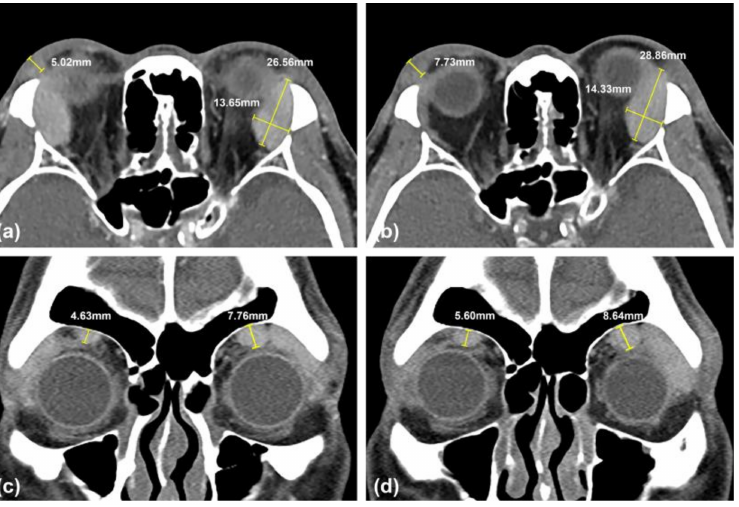
Figure 3. Contrast-enhanced CT of the orbits before orbitotomy ( a , c ) and six months after orbitotomy ( b , d ). ( a ) Axial view revealing bilateral enlargement of the lacrimal gland and right upper eyelid’s homogenous enhancement with an irregular border. The size of the left lacrimal gland was 26.56 mm × 13.65 mm. The thickness of the right upper eyelid mass was 5.02 mm. ( b ) Axial view revealing >90% reduction of the right lacrimal gland mass. The size of the left lacrimal gland was 28.86 mm × 14.33 mm. The thickness of the right upper eyelid mass was 7.73 mm. ( c , d ) Coronal view revealing bilateral enlargement of the supraorbital nerve. The diameter of the bilateral supraorbital nerve measured perpendicular to the frontal bone was 4.63 mm for the right eye and 7.76 mm for the left eye ( c ); 5.60 mm of the right and 8.64 mm of the left ( d